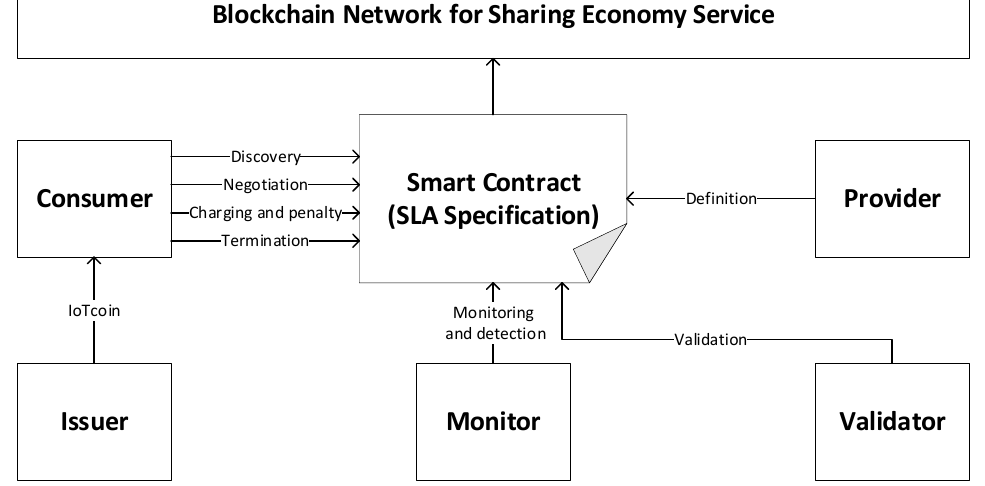
Figure 3. The relation between participants and the smart contract with the SLA specification in the proposed model.